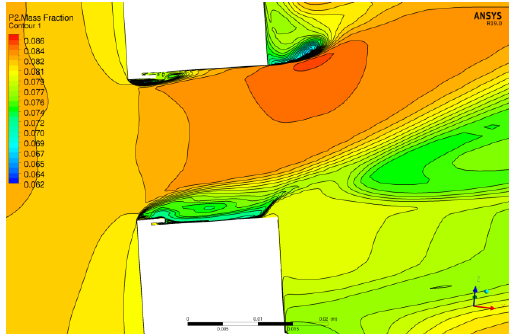
Fig. 10. Contours of steam wetness in the longitudinal cross- section of the probe